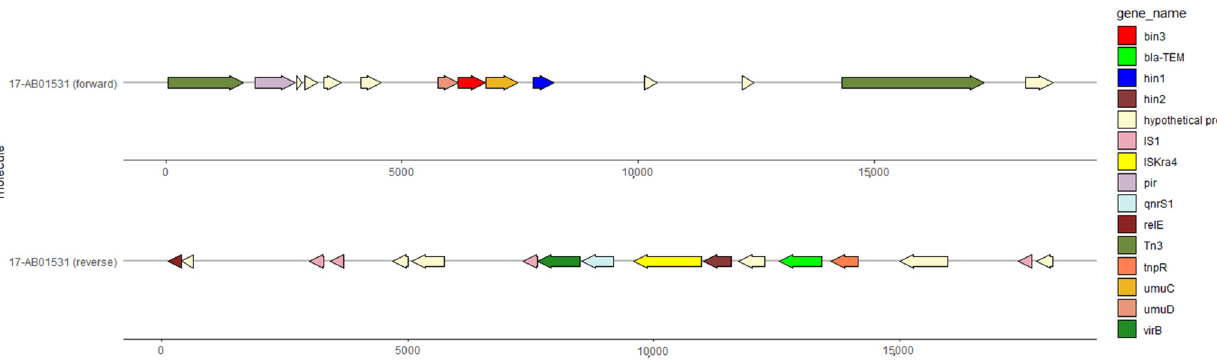
Figure 5. Structural organization of the qnrS1 -carrying contig of isolate 17-AB01531 derived from mapping against the unnamed reference plasmid (NZ_CP039972). Upper line represents the annotated forward strand. Lower line represents the annotated reverse strand.